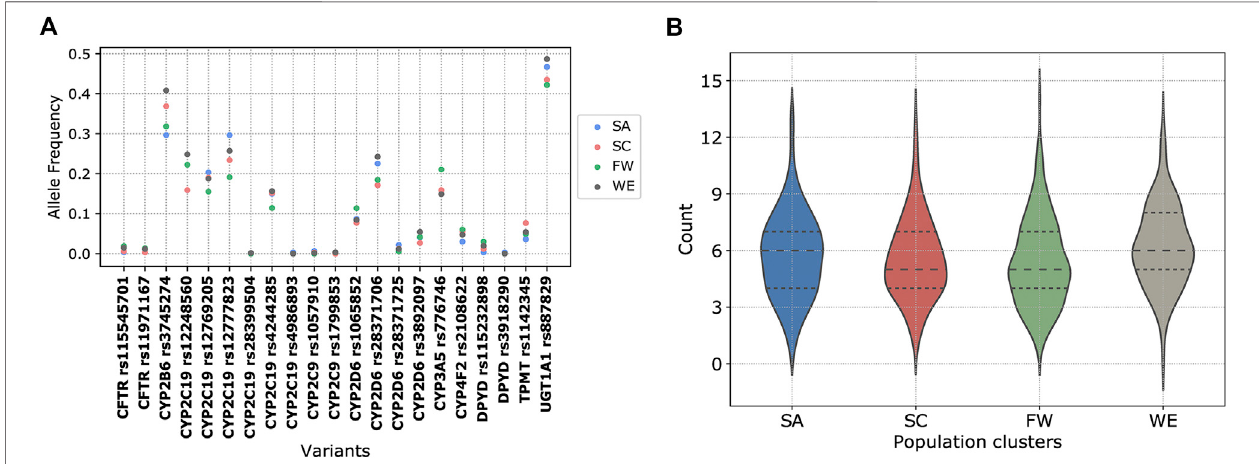
FIGURE10| Distributionofpharmacogenomicvariantswithahighlevelofclinicalannotation(PharmGKBlevel1A/B). (A) Scatterplotofallelefrequencyofclinically relevant variants in the PCA clusters. (B) Violin plot of the number of clinically relevant variants carried per individual grouped by the population clusters.